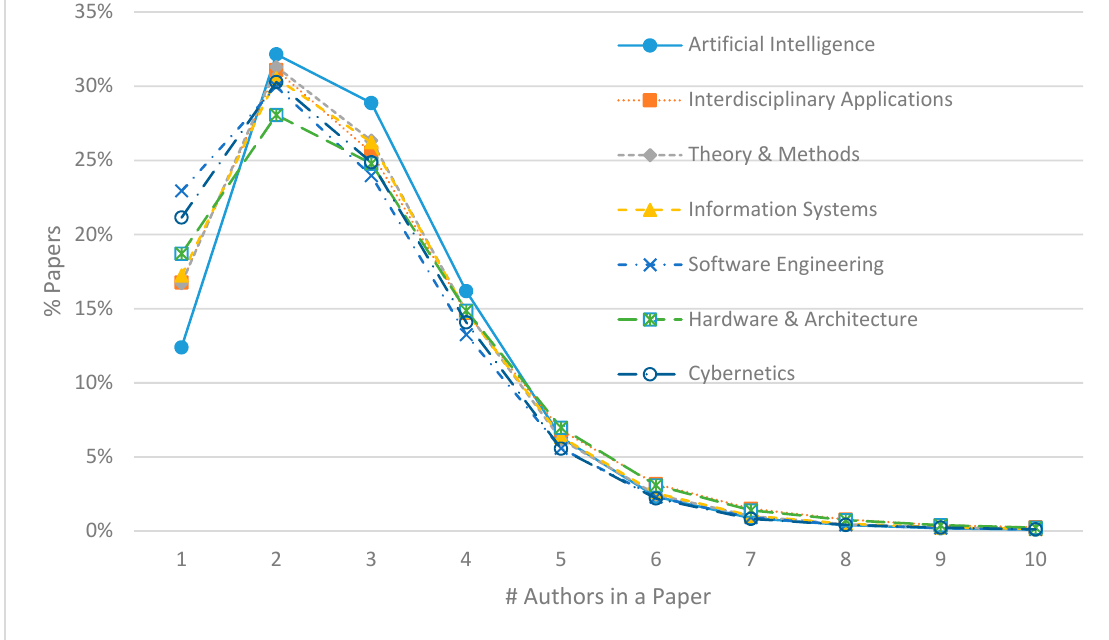
Table 4. Top 20 countries and their papers, citations, and citations per paper (CPP).